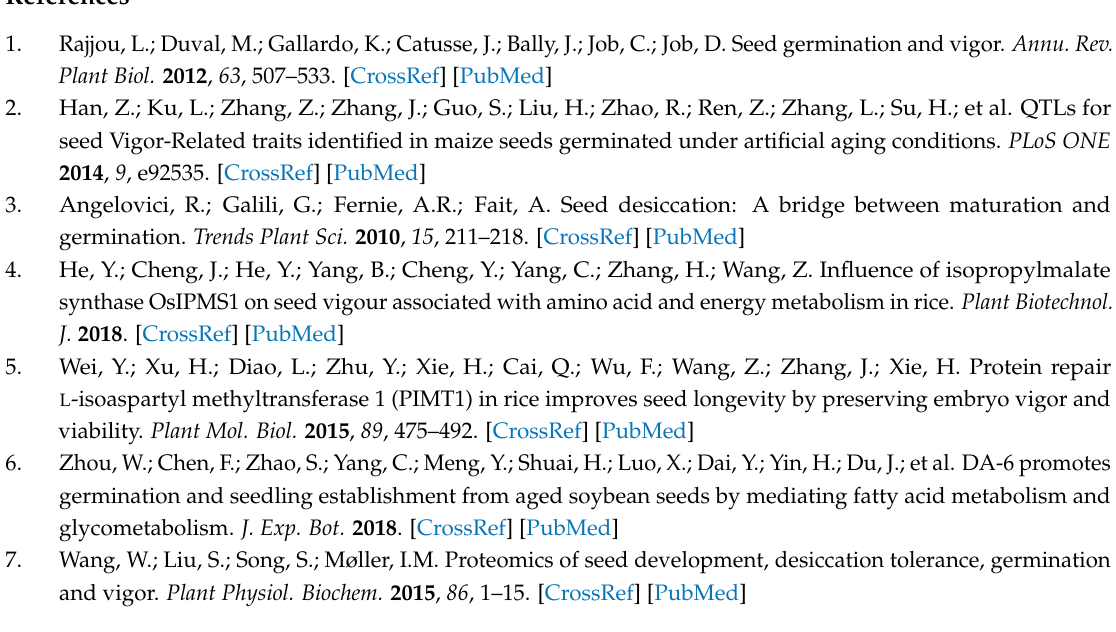
s1, Table S1: Summary of RNA-sequencing data, Table S2: Glutathione metabolism in KEGG enrichment, Table S3: Starch and sucrose metabolism in KEGG enrichment, Table S4: The soil mineral N (NO 3 − and NH 4+ ) (kg/ha) in the top 100 cm of soil profile before sowing at the period of wheat growth (October–June), Table S5: Primers used for